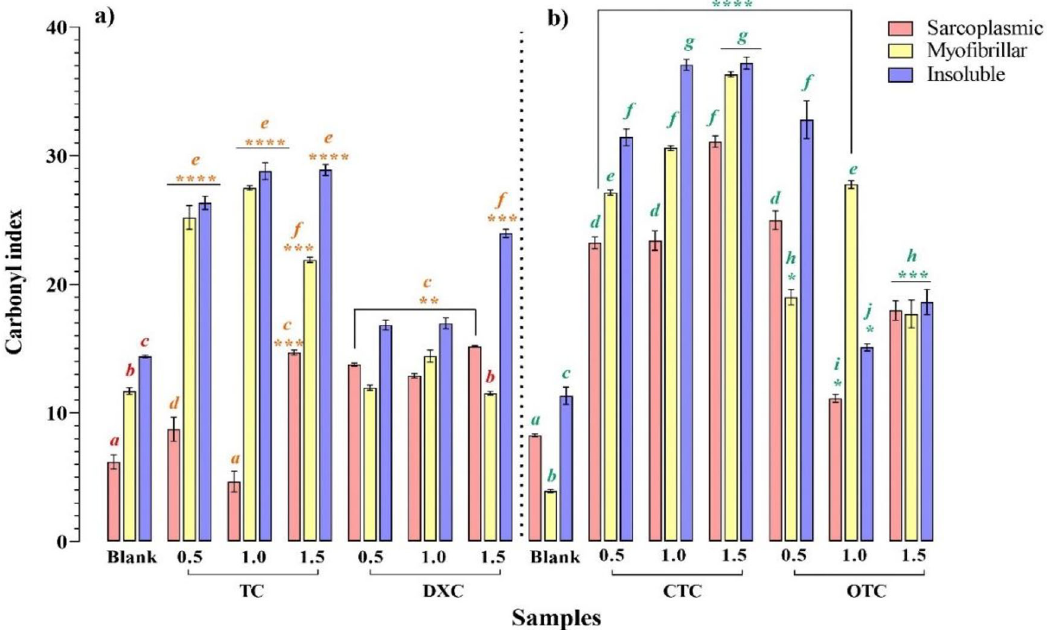
Figure 2. Changes in carbonyl content of sarcoplasmic, myofibrillar and insoluble chicken breast proteins induced by tetracycline (TC), chlortetracycline (CTC), oxytetracycline (OTC) and doxycycline (DXC). The col- umnsinthegrapharegroupedas:a)TCandDXCtreatment ´ sandtheirblanksb)CTCandOTCandtheirblanks.Mean values (cid:4) SEM. a-j Different letters on the bars denote statistically significant differences. Means having different superscripts differ between blank and tetracyclines concentration ( p < 0.05). **** p < 0.0001, *** p < 0.005, ** p < 0.05 denote statistically significant differences among treatment and their respective